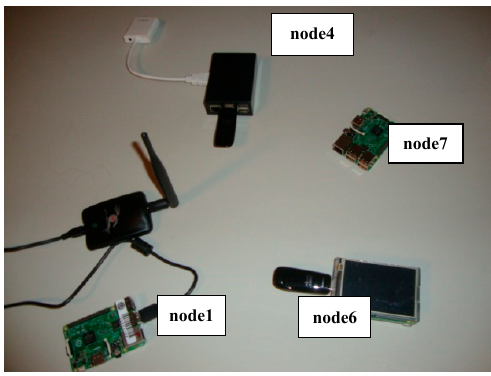
Figure 13. Image of our test platform.